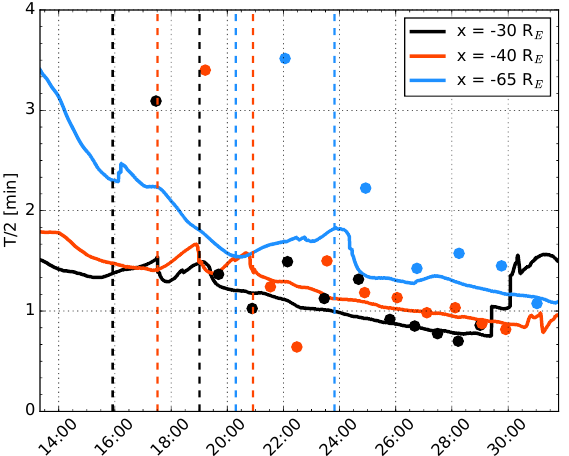
Figure 11. Travel time of magnetosonic waves across half of the magnetotail resonance cavity ( T/ 2) at distances x = − 30 R E (black), x = − 40 R E (red), and x = − 65 R E (blue) as a function of time (solid curves). For example, T/ 2 at x = − 40 R E has been es- timated by integrating d t = d z/V ms over the distance between the magenta curves marked in Fig. 10 and dividing by 2. The dots indi- cate tail flapping half periods with color indicating the correspond- ing x coordinate. The flapping half periods have been obtained as the time differences between consecutive magenta dots indicated in Fig. 4, and they have been associated with a time stamp correspond- ing to the average of the two times. The dashed vertical lines show the start and end times of the first flapping signature at the three